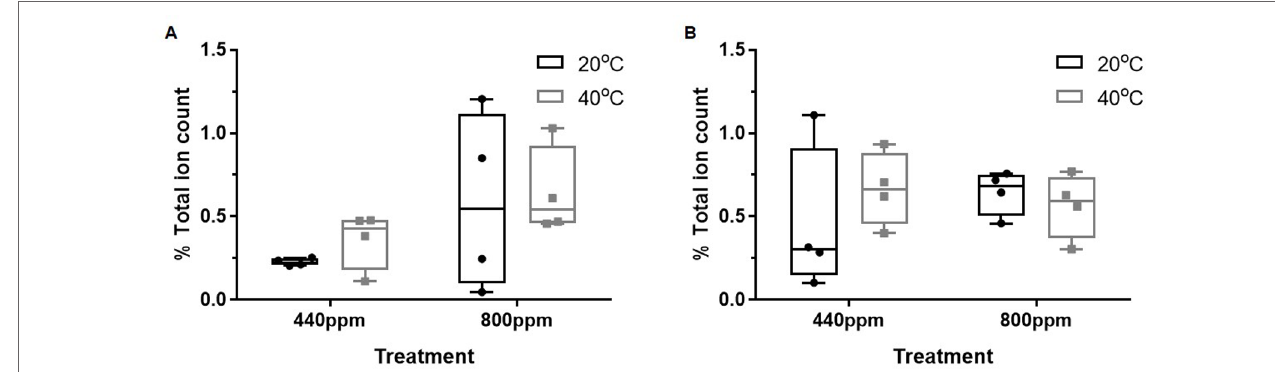
FIgURE 4 | Total % ion count of discriminatory mass bins ( m/z) from MALDI-ToF analysis of polar phase, negative ionisation mode. The mass bins represented are defined as containing putatively identified secondary metabolites involved in glycolysis and the shikimate pathway that show greater abundance of %TIC of the secondary metabolites within the bins under the CO 2 and temperature treatments when compared to the control treatment. (A) (bin 385) and (B) (bin 365). Each point represents a pooled replicate per plant across the four treatments. Bars represent minimum and maximum